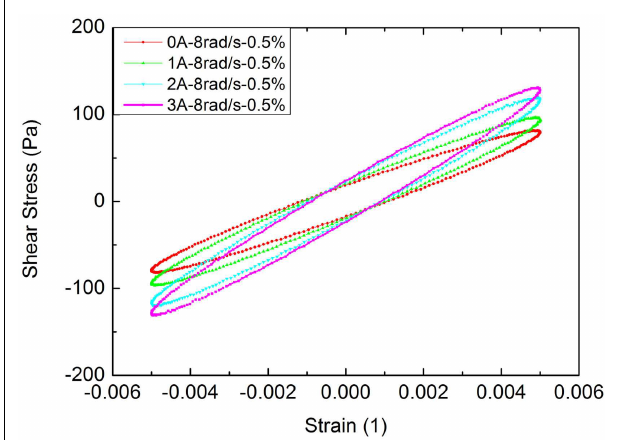
FIGURE 6 | Magneto-rheological effect of MRE .